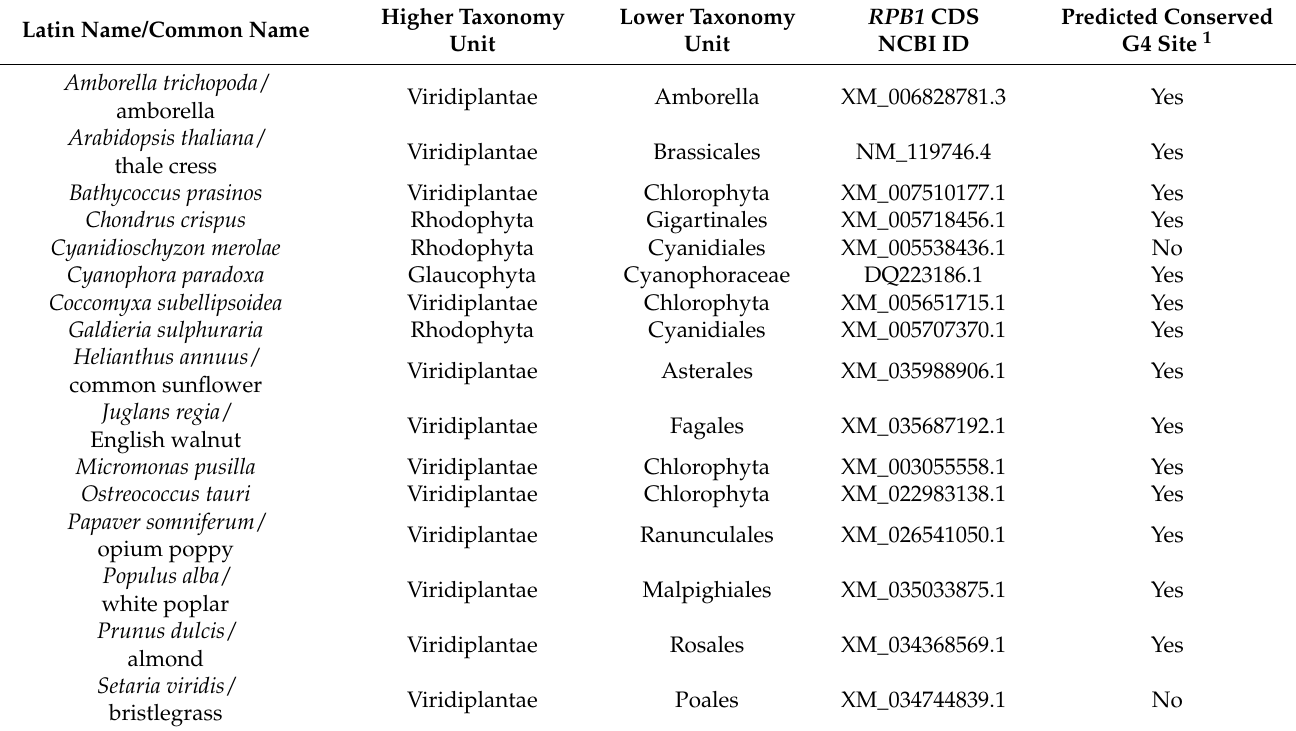
Table 1. The most important species inspected in this study (for more species, see Supplementary Material S1). Columns contain their Latin and common names (if applicable, higher and lower taxonomy units, NCBI accession numbers of RPB1 coding regions, and the presence of predicted conserved G4